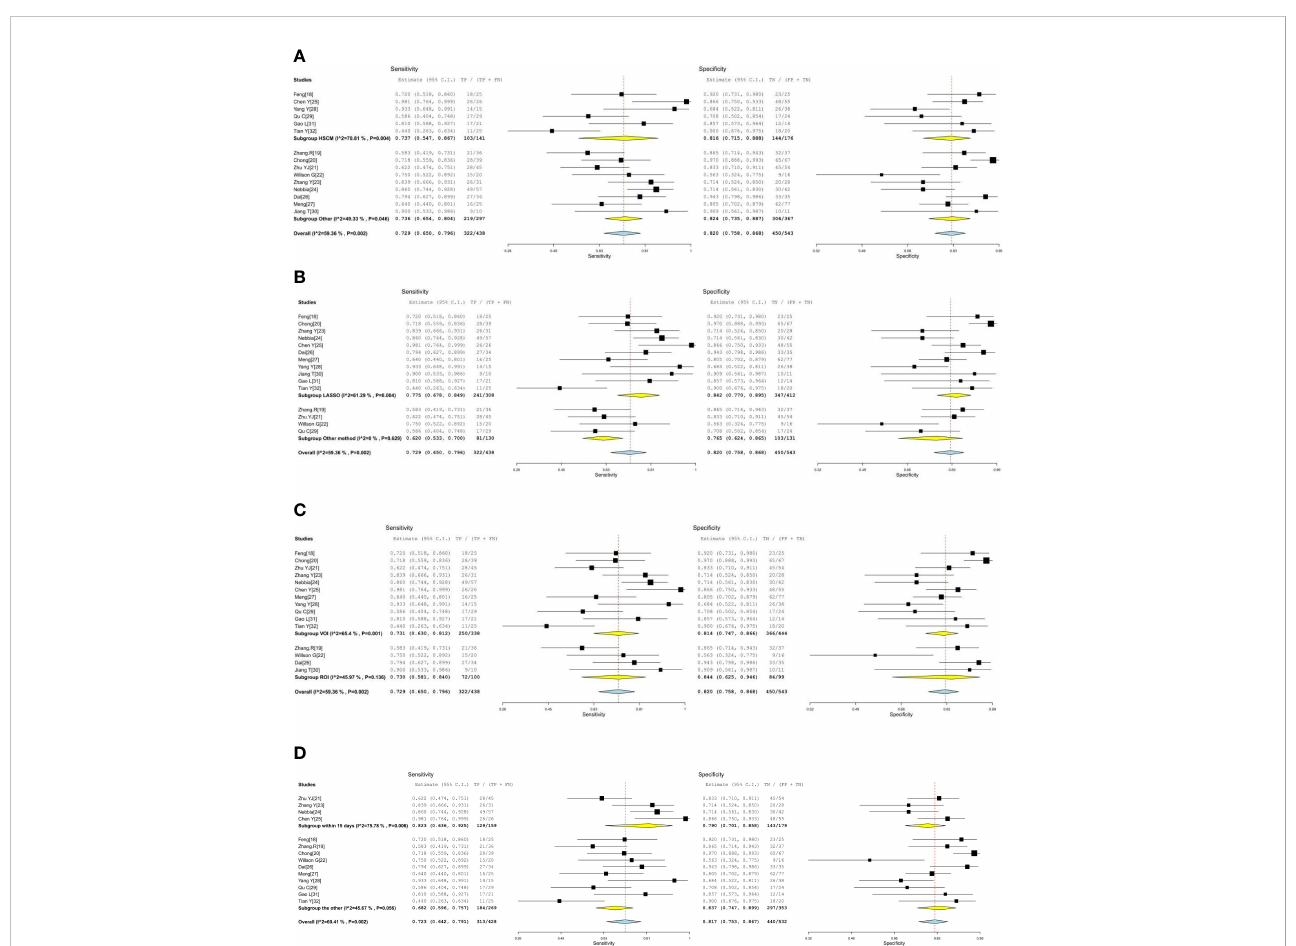
FIGURE 5 (A, B) The forest plots of subgroup analysis. (C, D) The forest plots of subgroup